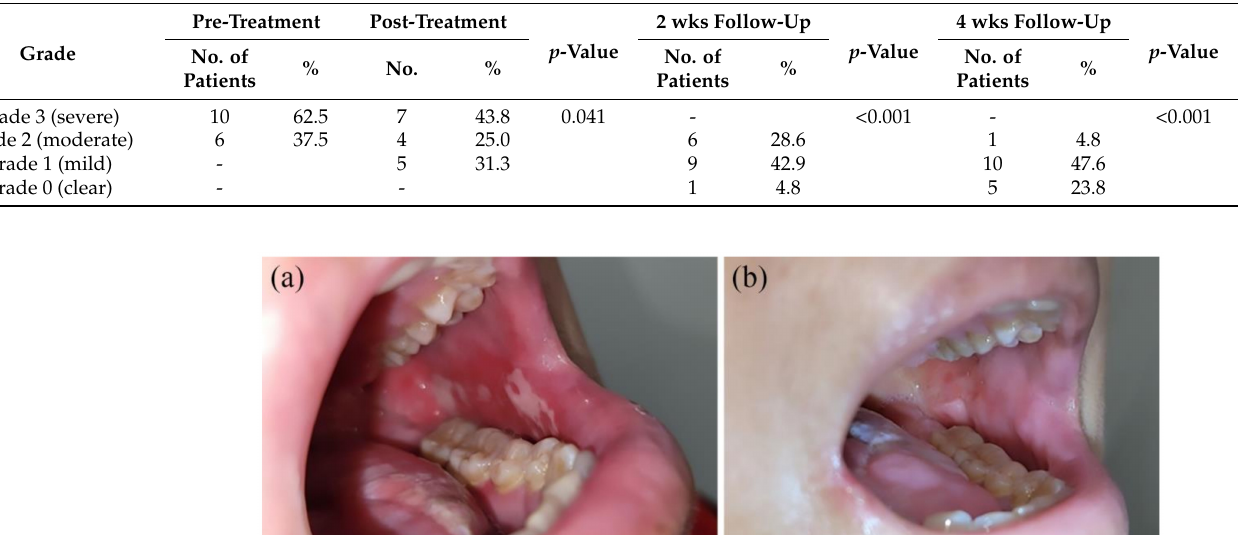
Figure 2. Changes in mean WHO grade of OM with time ( p < 0.001). Table 4. Distribution of OM grades before and after PBMT.